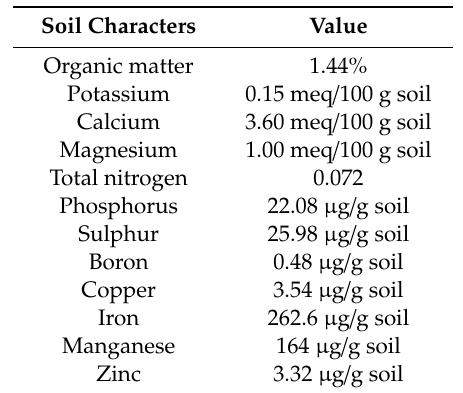
Table 1. The chemical composition of the soil of the experimental site as observed prior to experimentation (0–15 cm depth).